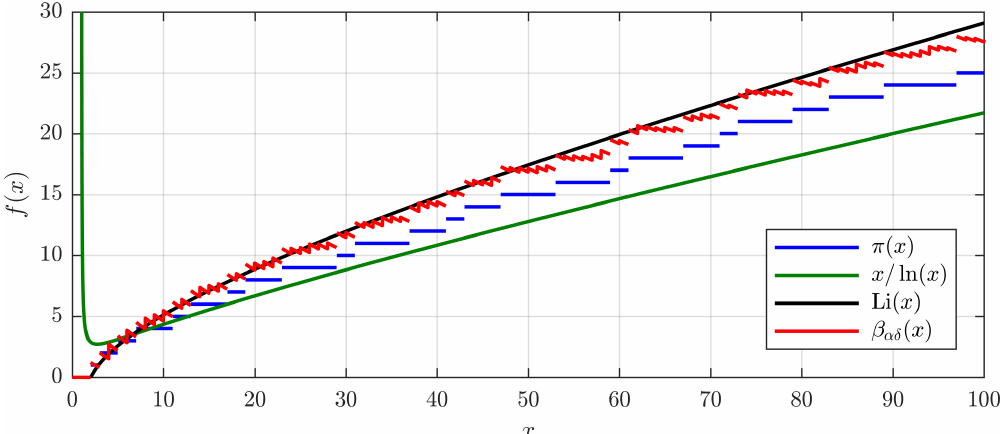
Figure 1. The prime counting function π ( x ) and its